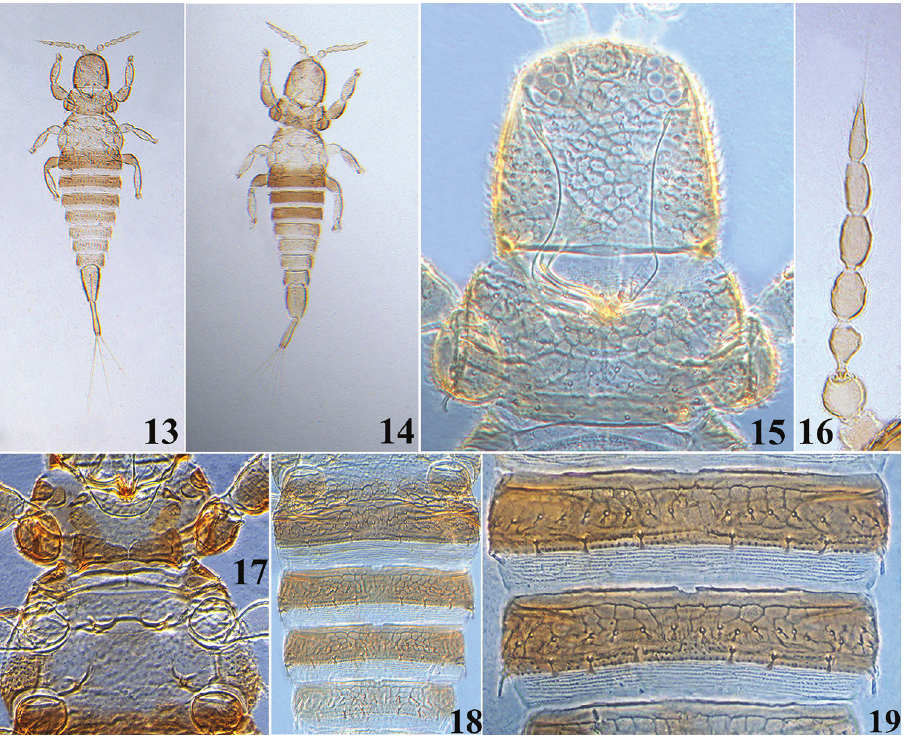
17 pro, meso and meta sternum 18 abdominal tergites I–V 19 abdominal tergites III–IV. brown; antennal segments II–VII tinged with light brown; tergites V–IX yellow shad- ed with brown laterally; tube yellow with extreme apex